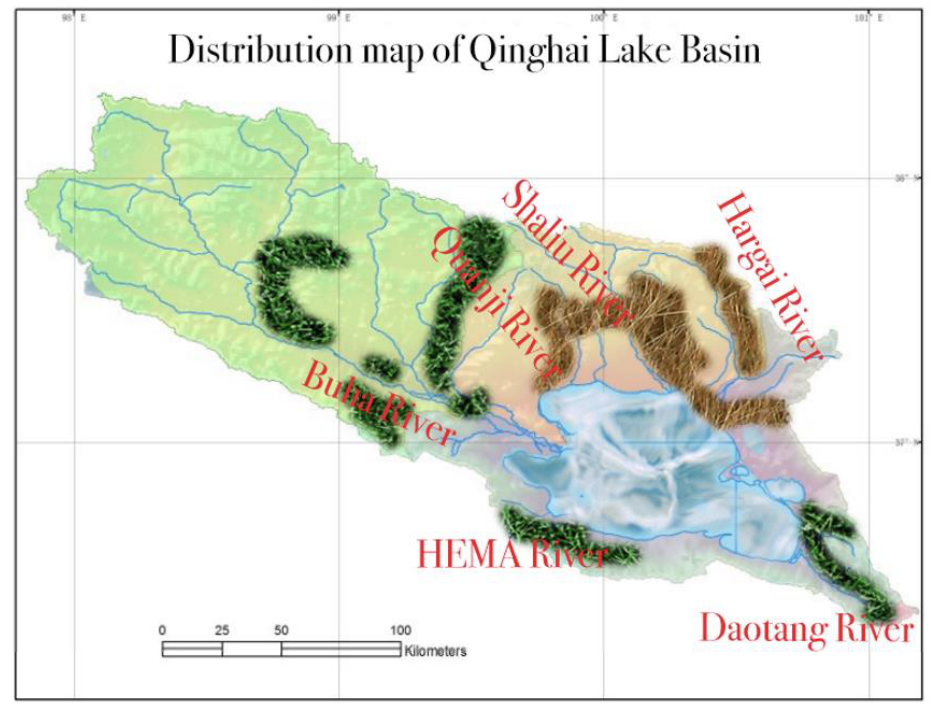
Figure 2. Distribution map of Qinghai Lake Basin.